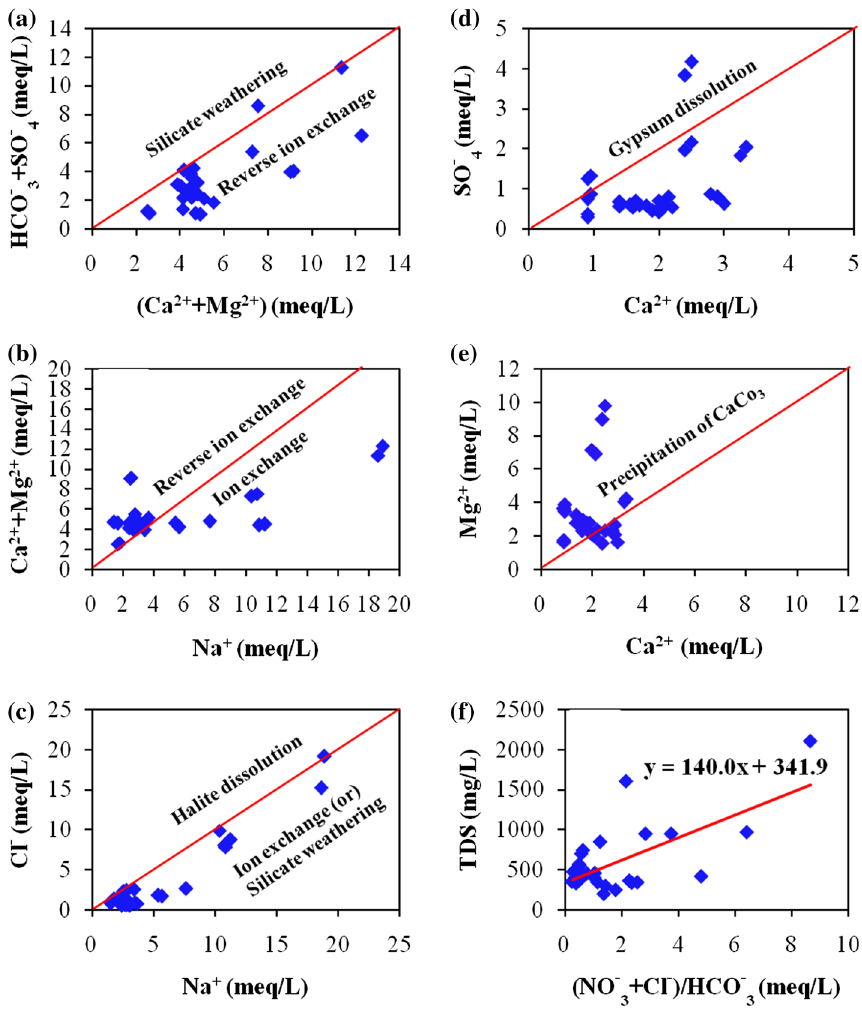
Fig. 5 Correlation between a (Ca 2+ + Mg 2+ ) and HCO − SO 2 − ( 3 + 4 ), b Na + and (Ca 2+ + Mg 2+ ), c Na + and